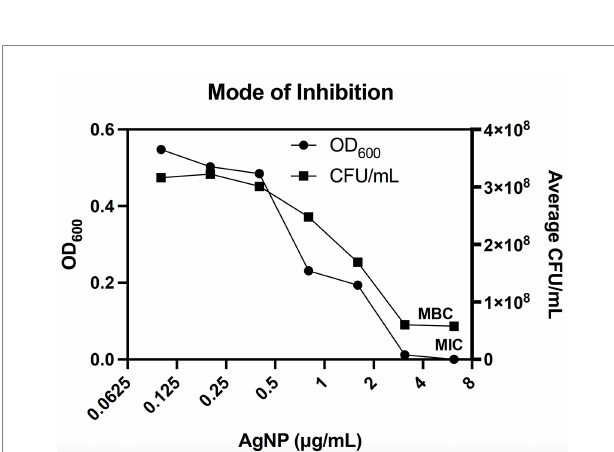
FIGURE 3 AgNPs are bactericidal against E. coli . The minimum bactericidal concentration (MBC) of Formula 1.1 AgNPs for E. coli DH5 α was 6.2 μ g/ mL, while the MIC was 3.1 μ g/mL. The ratio between the two values is 2, indicating a bactericidal mode of inhibition. Bacterial growth was assessed by measuring OD 600 for 20 h, followed by plating for CFUs. The MIC and MBC points are marked on the graph. Data represent three independent experiments with three internal replicates per